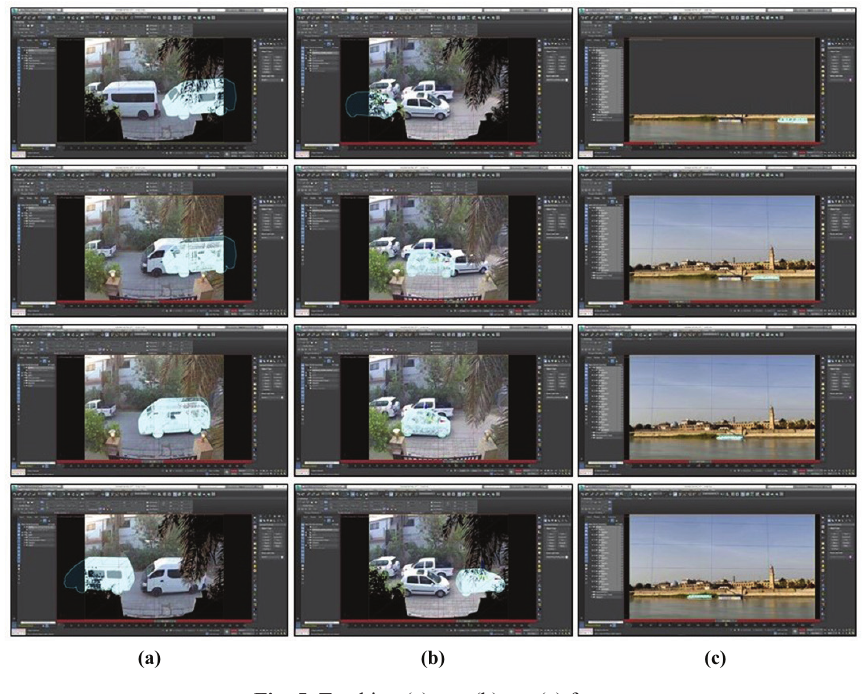
Fig. 5. Tracking (a) van (b) car (c)